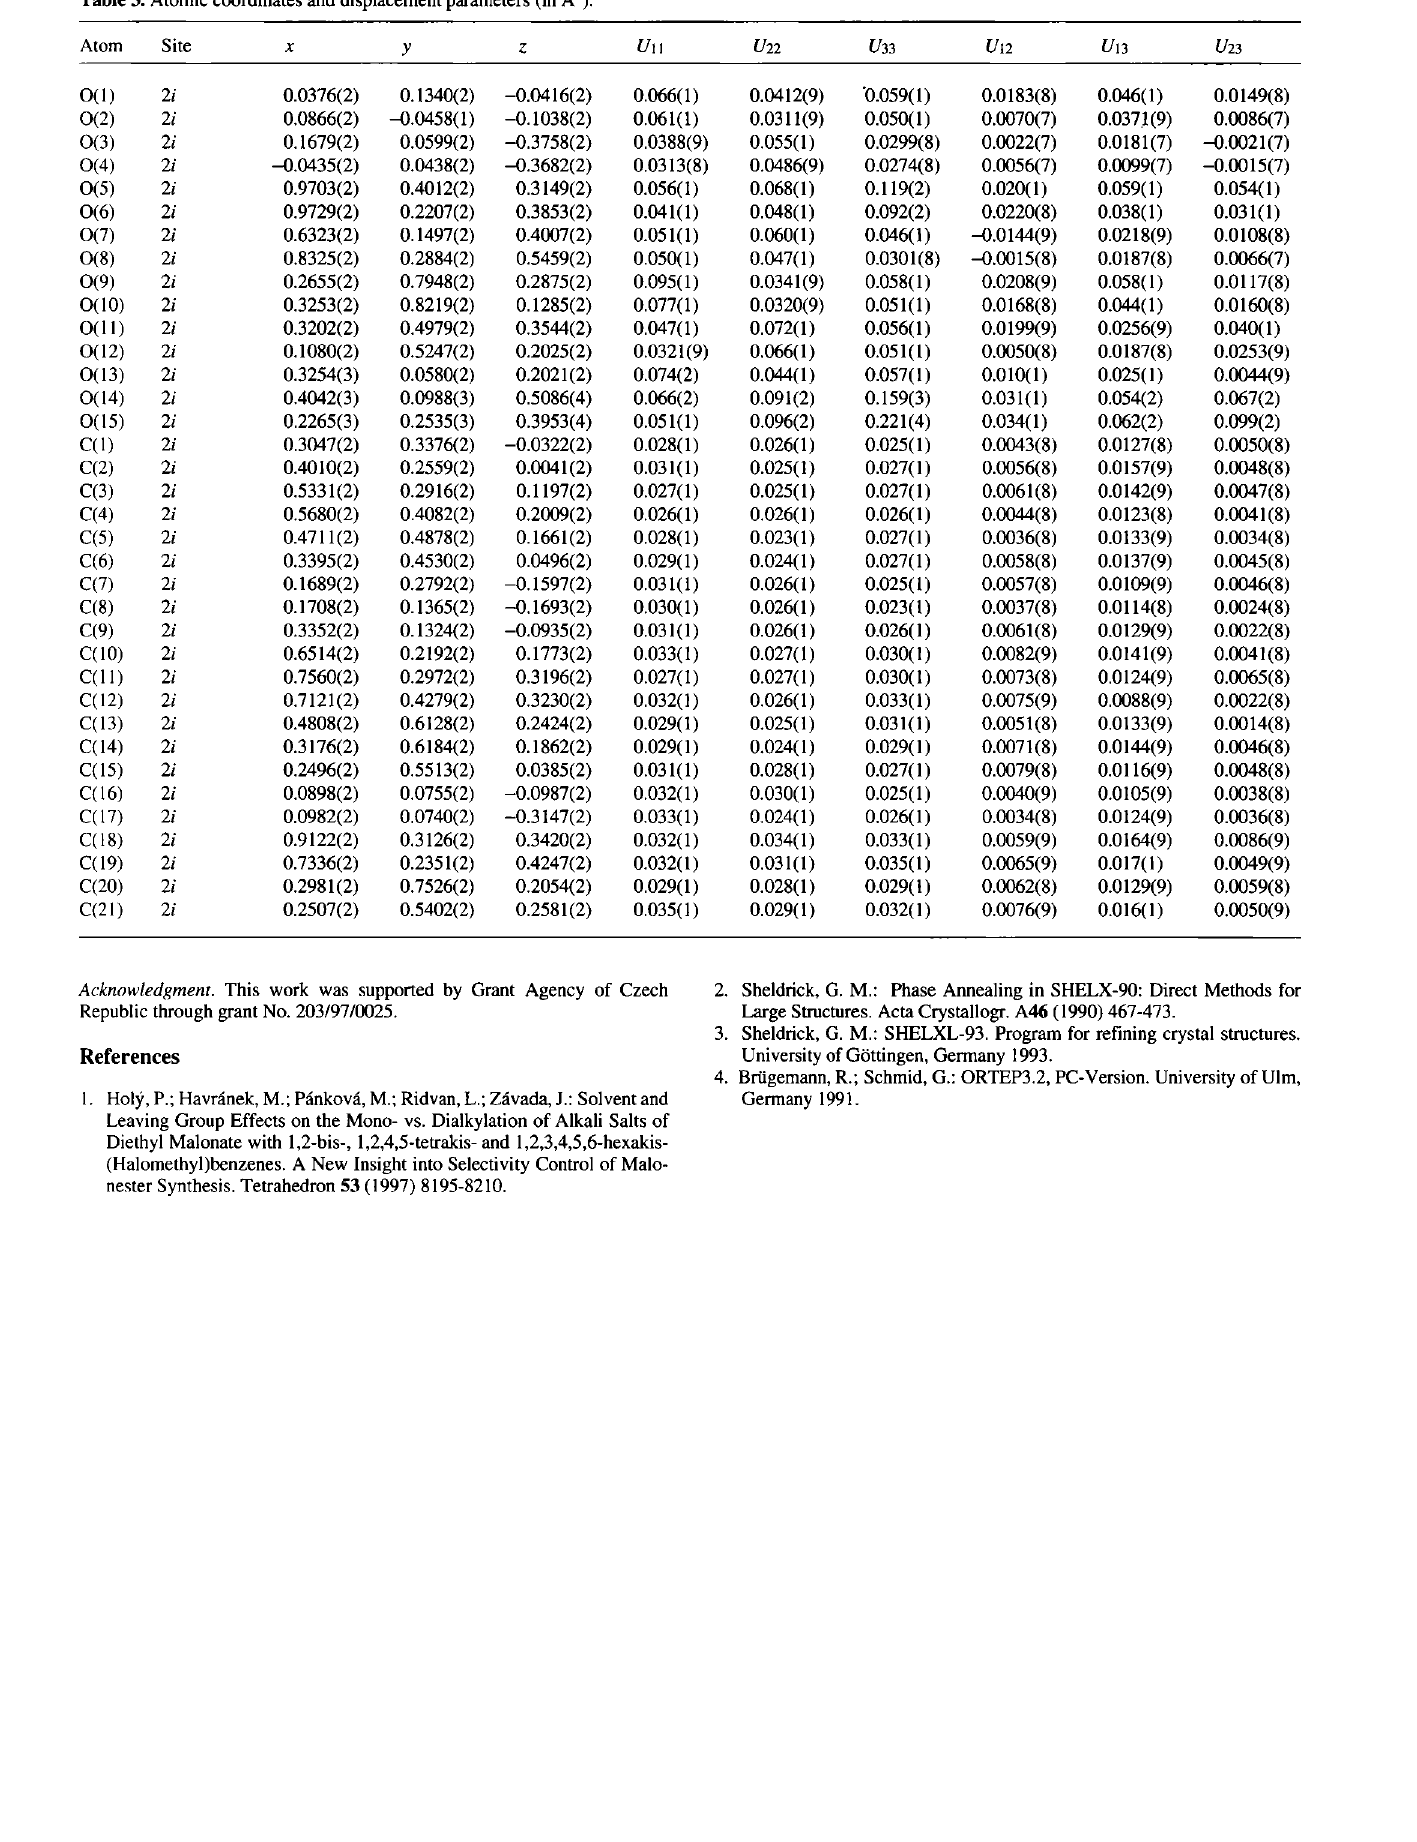
Table 3. Atomic coordinates and displacement parameters (in Ä 2